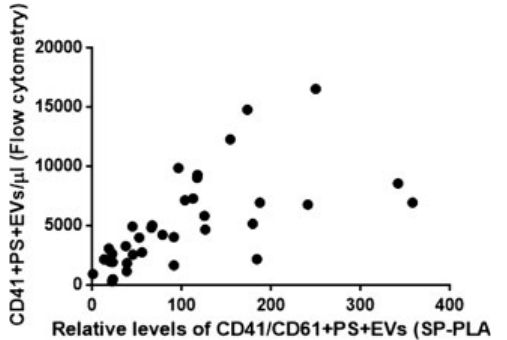
Fig. 5 Correlation between SP-PLA and high-sensitivity fl ow cytometric measurements of platelet-derived EVs. SP-PLA measurements of platelet- derived EVs in plasma from REBUS patients (relative to EV-free plasma that was set to 1) were plotted against CD41 þ AnnV þ EVs counted by high- sensitivity fl ow cytometry using the CytoFLEX (Beckman Coulter) with the gate set by polystyrene beads on 0.1 – 0.9 μ m particles .Correlation was determined using the Pearson product-moment correlation coef fi cient (R ¼ 0.65, p < 0.0001, n ¼